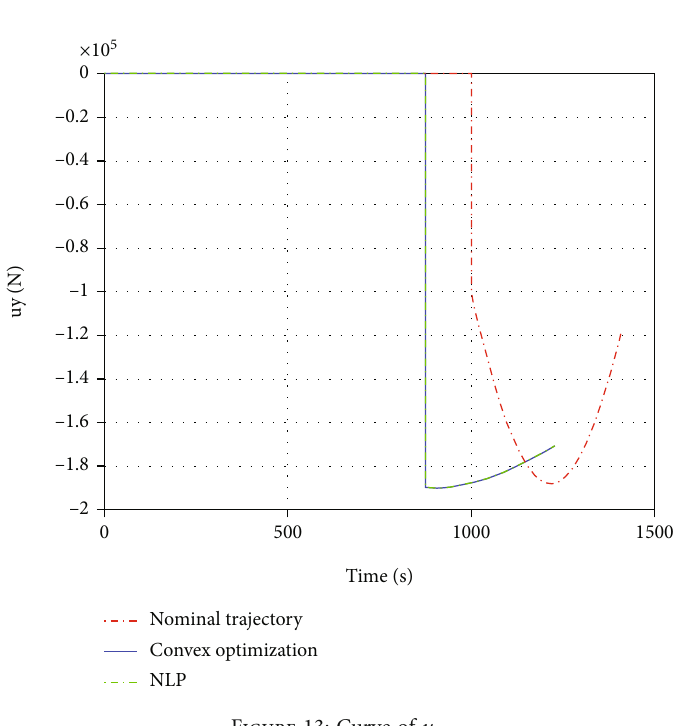
Figure 13: Curve of u